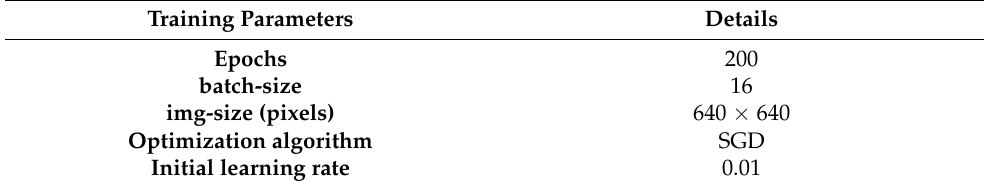
Table 2. Training parameters for forest fire and smoke detection models.